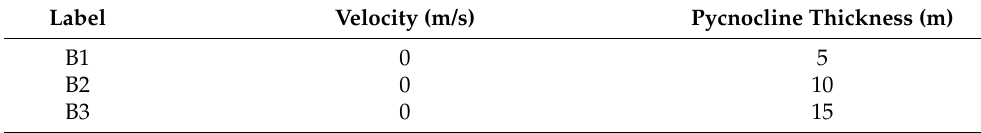
Table 4. Three cases of the submarine against ISWs with different pycnocline